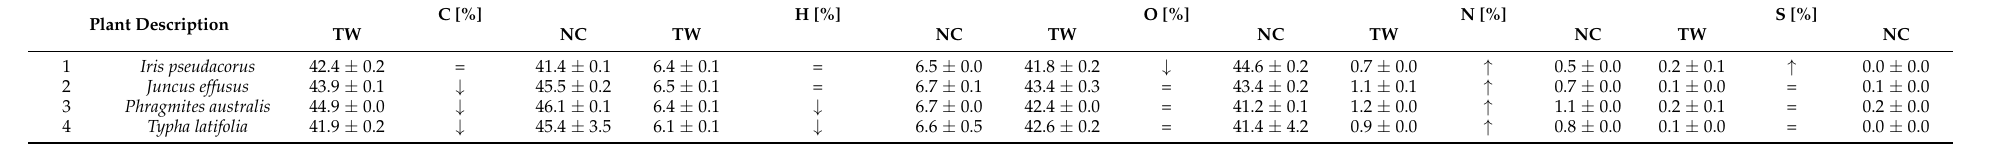
Table 2. C, H, O, N, S content in the selected plants for the different growing